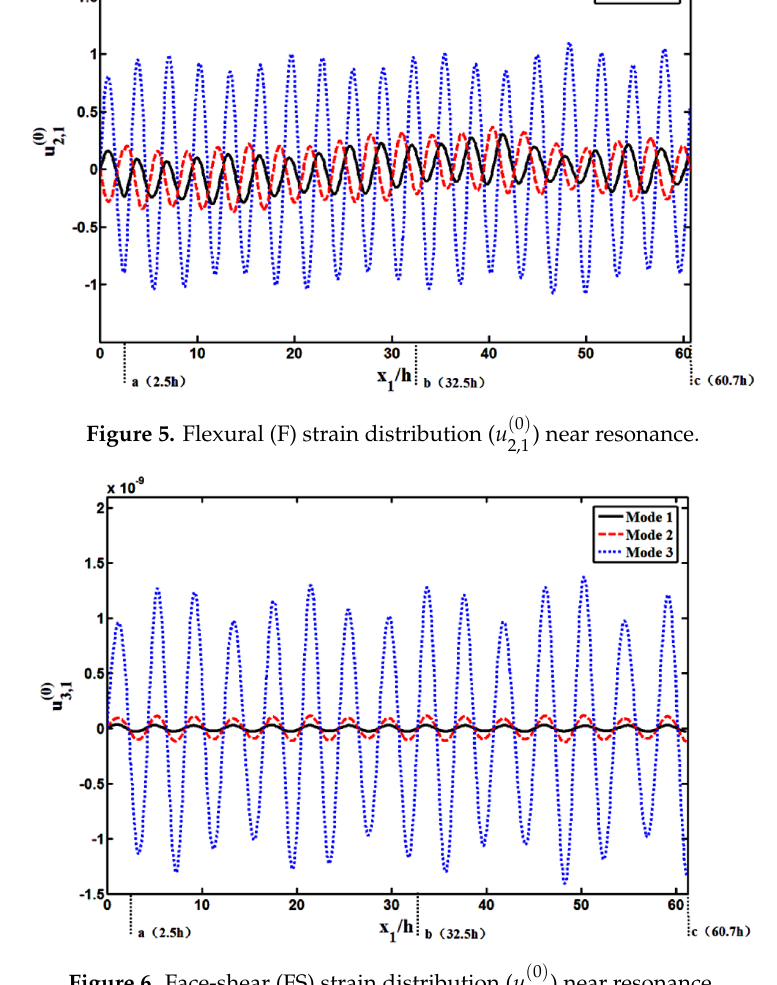
Figure 6. Face-shear (FS) strain distribution ( 0